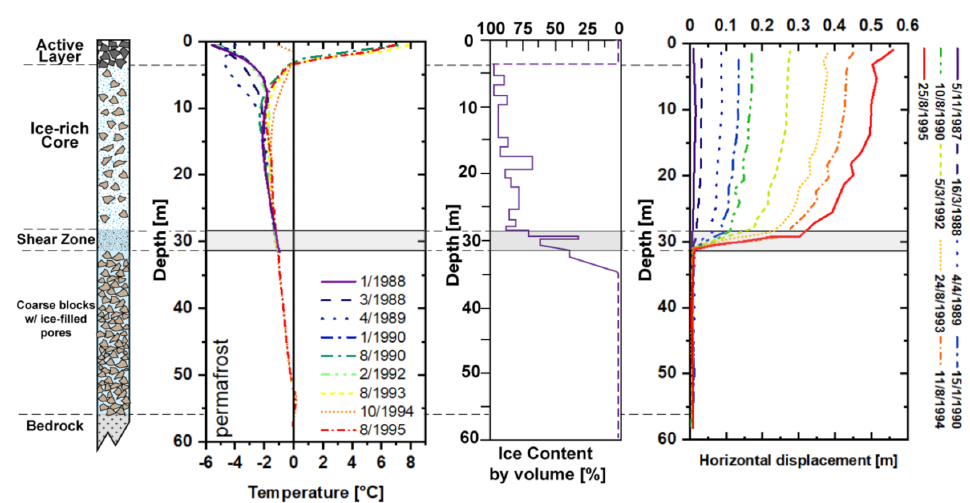
Figure 5. Stratigraphic column, temperature profile along the rock glacier body, ice content by volume and displacement at depth for the Murt é l-Corvatsch rock glacier (modify after [21]).